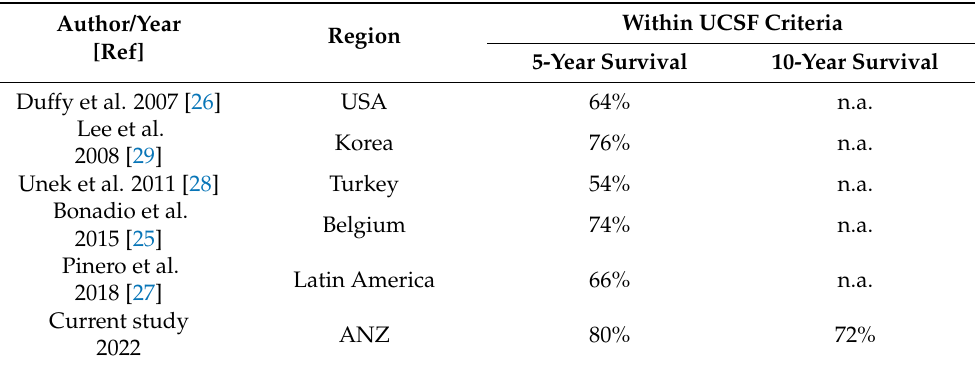
Table 4. Comparison of 5- and 10-year overall survival rates following liver transplantation for hepatocellular carcinoma within the University of California San Francisco (UCSF) criteria from large series around the world. Within UCSF Criteria Author/Year Region [Ref] 5-Year Survival 10-Year Survival Duffy et al. 2007 [26] USA 64% n.a. Lee et al. 76% n.a. 2008 [29] Unek et al. 2011 [28] 54% n.a. Bonadio et al. Belgium 74% n.a. 2015 [25] Pinero et al. 66% n.a. 2018 [27] Current study ANZ 2022